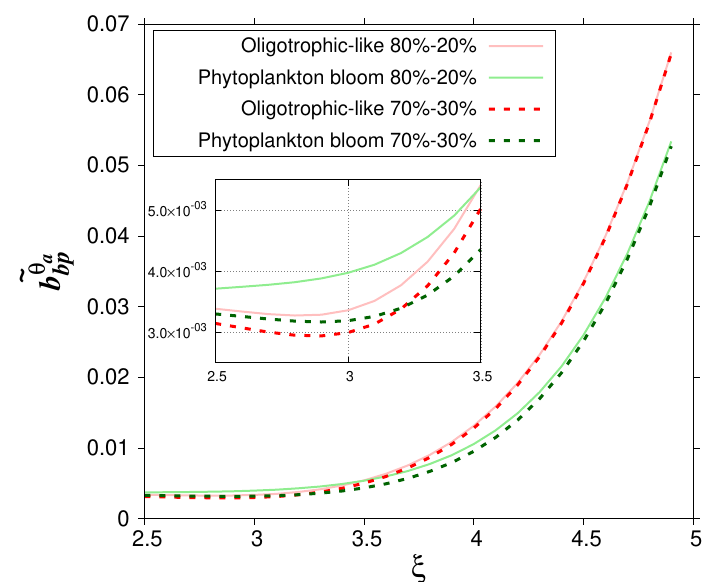
Figure 6. Particulate backscattering ratio as a function of the hyperbolic slope for oligotrophic-like and phytoplankton bloom water bodies. Phytoplankton cells are modeled as two-layered spheres with a relative volume of the chloroplast of 20 % and 30 %, as indicated.